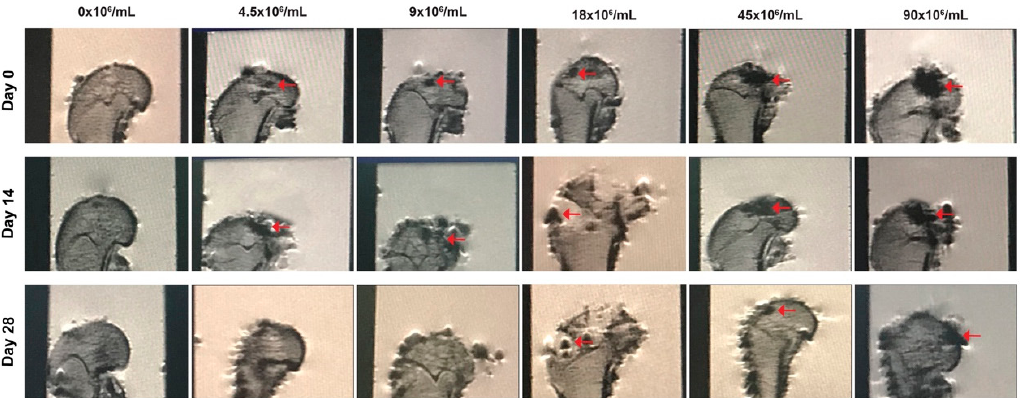
Figure 9. In vivo MRI imaging of hydrogel constructs containing UCNP@SiO 2 -TS-labeled CSPCs of increasing numbers (4.5–90 × 10 6 cells/mL) in cartilage-defect model. MRI of the injected constructs (indicated by red arrows) on days 0, 14, and 28.